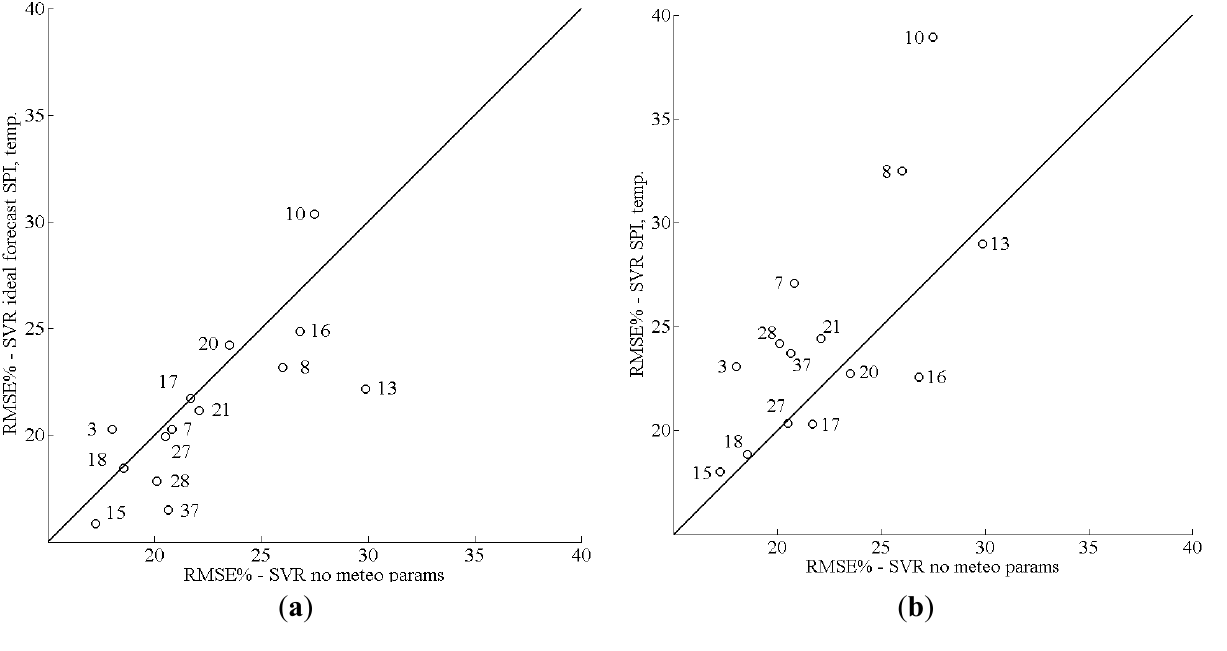
Figure 7. Comparison between the RMSE% obtained on the test set with (y axis) and without (x axis) SPI and temperature as SVR input feature. In ( a ) the actual target of SPI and temperature in the target month is employed (simulating an ideal forecast of this variable); In ( b ) the past time series of SPI and temperature is adopted. Both scatterplots refer to the performances obtained by the SVR trained for the prediction with a lag equal to one